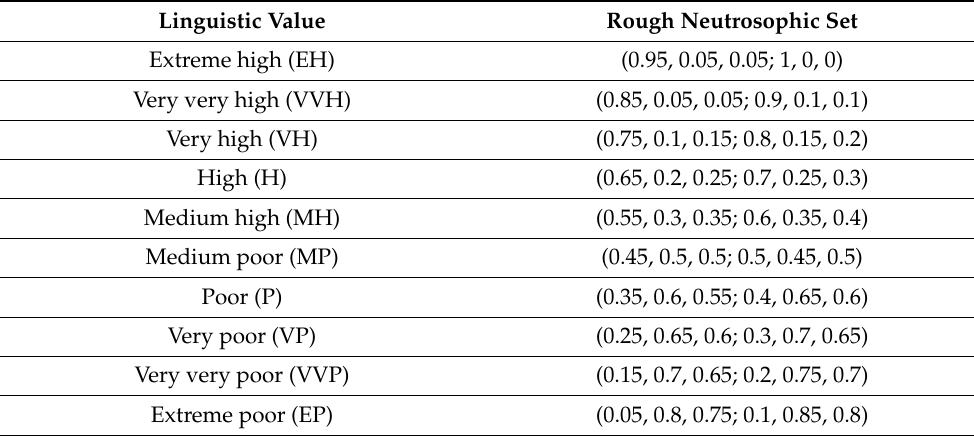
Table 4. Linguistic values and rough neutrosophic sets for alternatives’